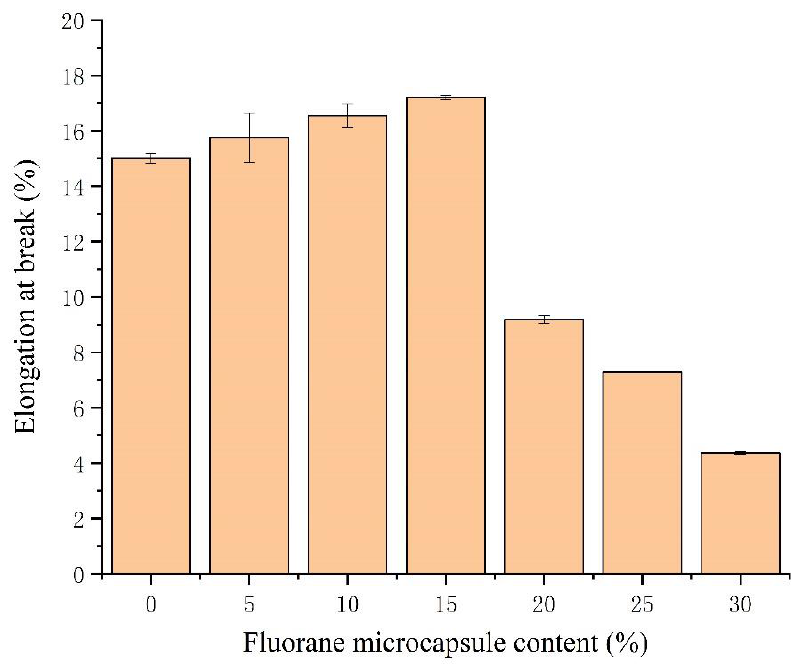
Figure 11. The fluorane microcapsule content on film elongation at break. Table 7. The fluorane microcapsule content on mechanical properties.